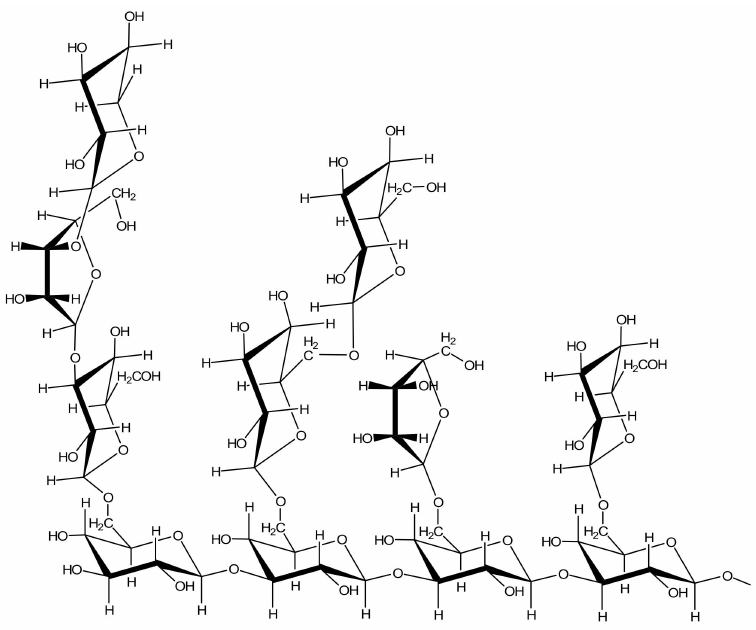
Figure 4. Fragment of a branched polysaccharide arabinogalactan